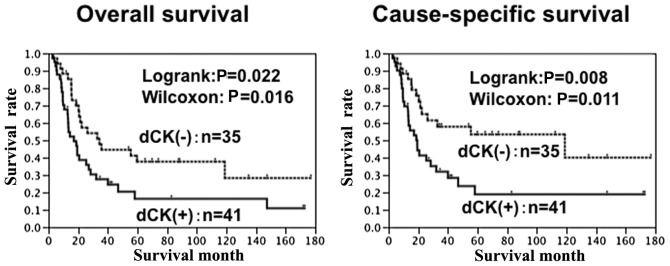
Survival curves of the esophageal squamous cell carcinoma (ESCC) patients. The left panel shows overall survival and the right panel shows cause-specific survival. The prognosis of the patients with a high expression of deoxycytidine kinase (dCK) was significantly worse than that of the patients with a low expression of dCK.